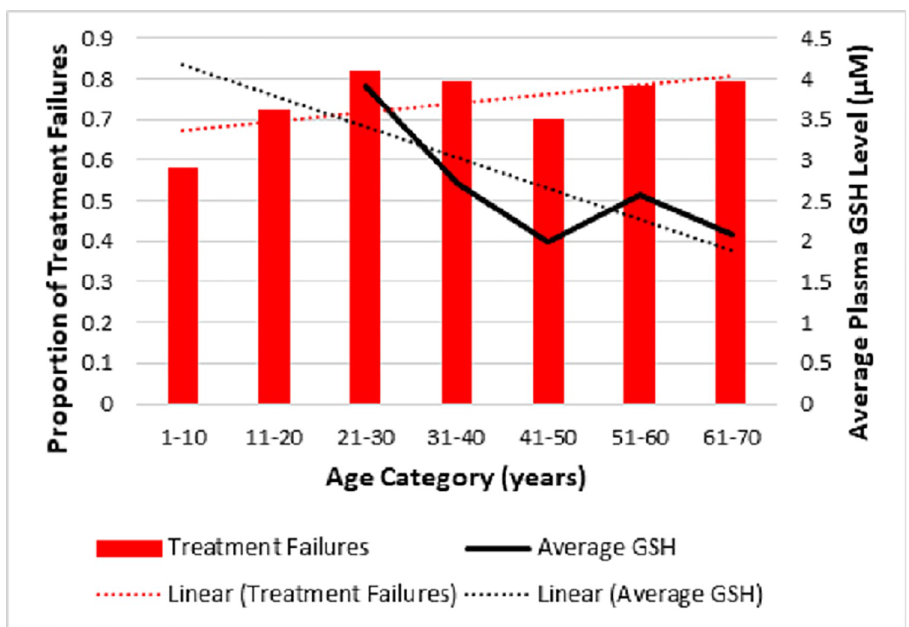
Fig 2. Proportion of treatment failures versus age category with average plasma glutathione (GSH) levels adapted from Giustarini et al, 2006 [69].